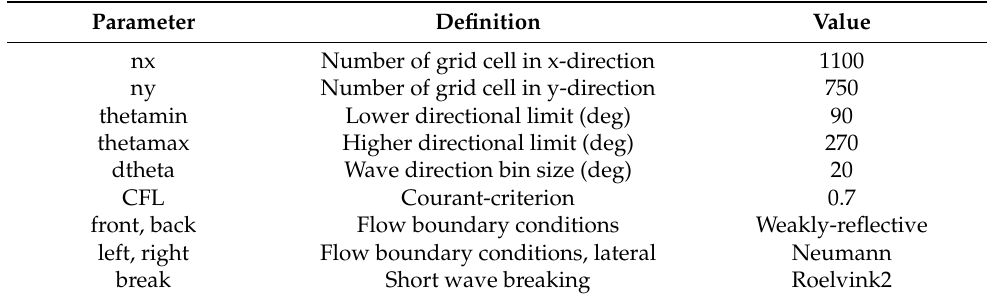
Table A1. General input parameters for model D1 (D2 only has grid parameters different from D1).